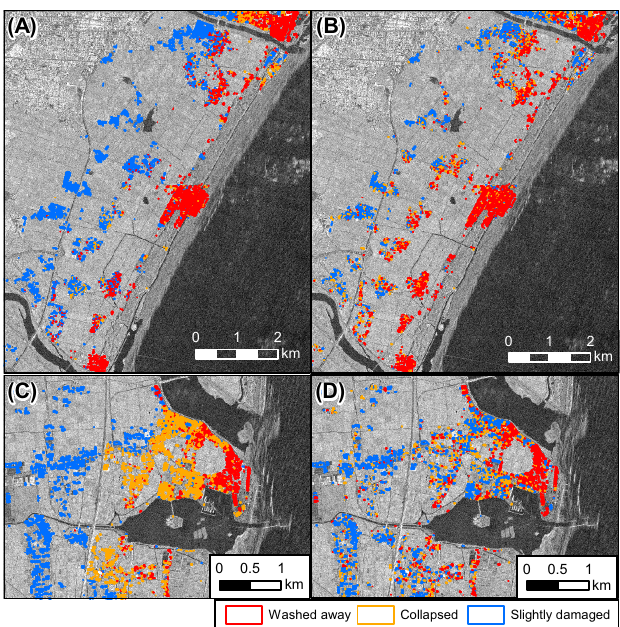
Figure 10. Results of building damage classification in the affected areas of the 2011 Tohoku tsunami [46]. The method was performed in Sendai city and a test of the transferability of the developed model in the town of Watari. ( A ) ground truth data in Sendai City; ( B ) classification result in Sendai City; ( C ) ground truth data in the town of Watari; ( D ) classification result in the town of